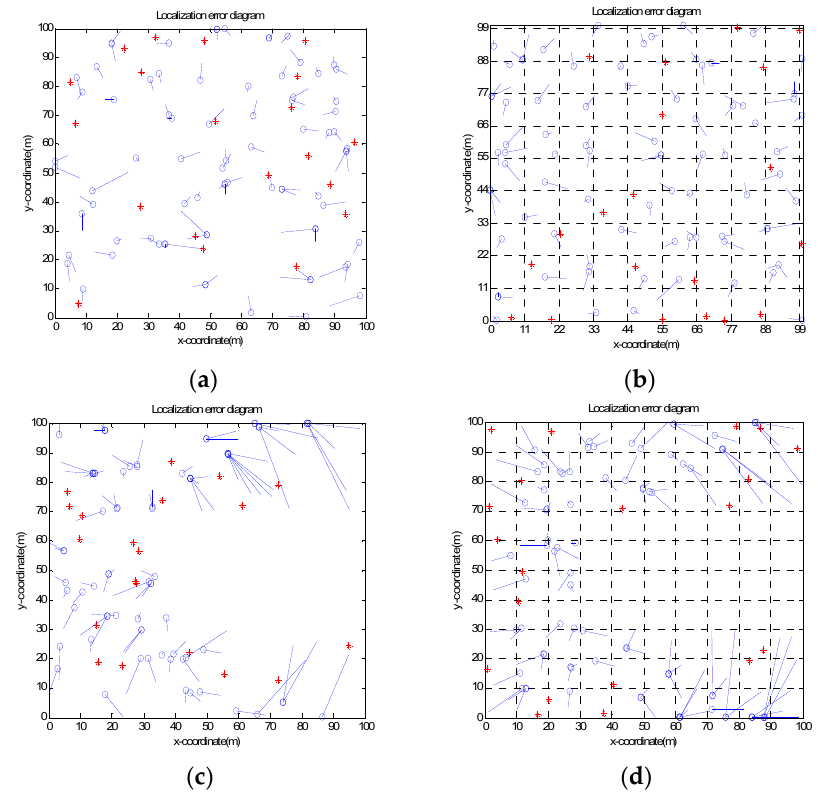
Figure 2. ( a ) Node error distribution diagram in square random topology; ( b ) Node error distribution diagram in a square grid topology; ( c ) Node error distribution diagram in C-Shaped random topology; ( d ) Node error distribution diagram in C-Shaped grid topology. Table 1. Parameter settings of DEIDV-Hop.